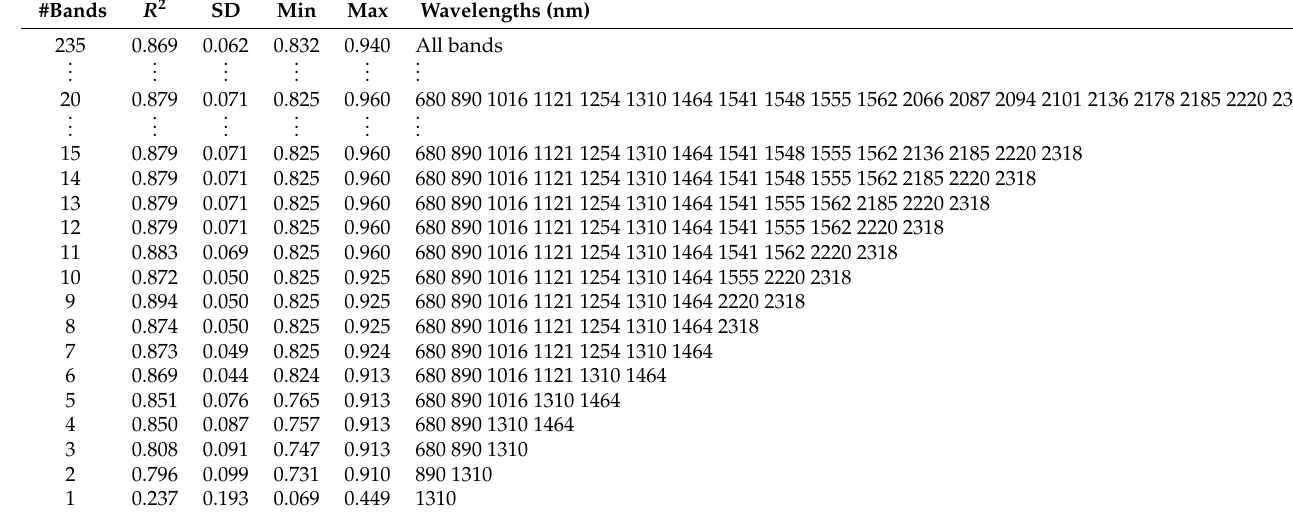
Table 3. An SBBR example of a CCC variable with goodness-of-fit statistics based on 3-fold cross- validation as run by GPR-BAT.